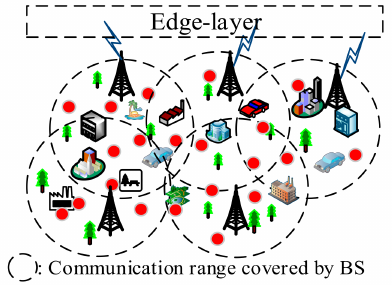
Figure 2. The Access-layer of